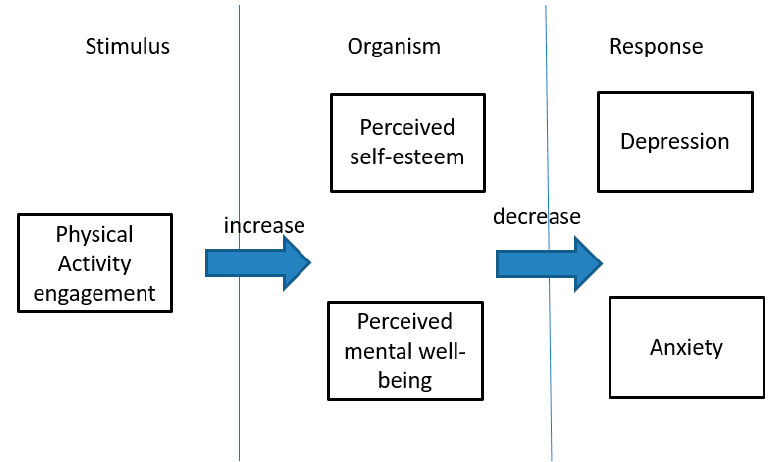
Figure 1. Conceptual framework proposed (source: authors).